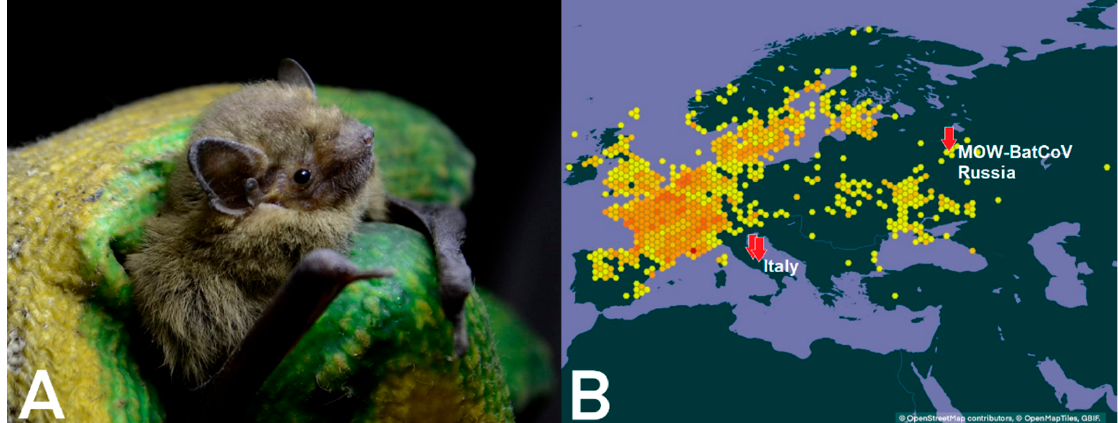
Figure 1. ( A ) P. nathusii , also known as Nathusius’ pipistrelle, studied here; ( B ) geographical distri- bution of P. nathusii in Europe. The dark-yellow spots represents its habitat in accordance with data present on web-site devoted to zoology [45]. The red arrows represents the location in Europe where different MERS-related Bat-CoVs were found.